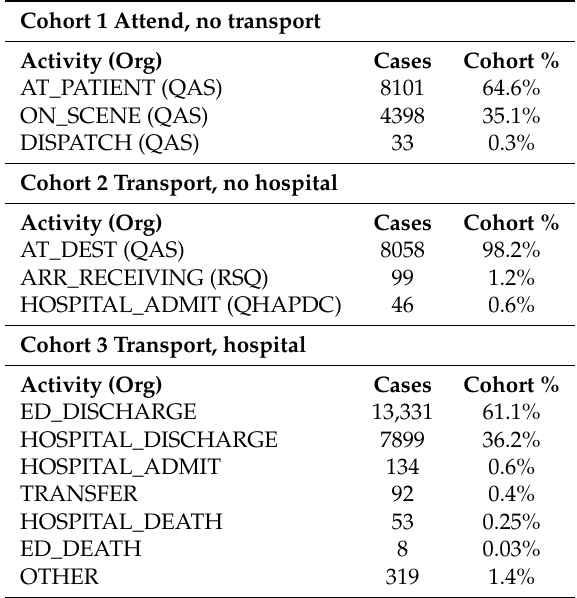
Table 3. Outcome by cohort as given by last recorded